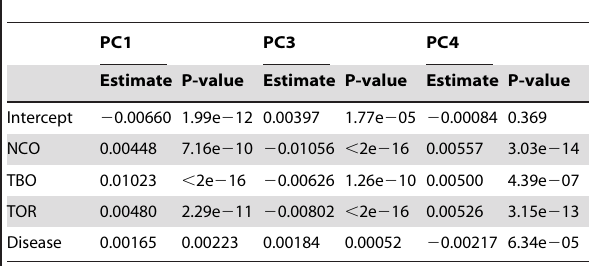
Table 5. Association of PCs 1, 3 and 4 from GWAS PCA to site.